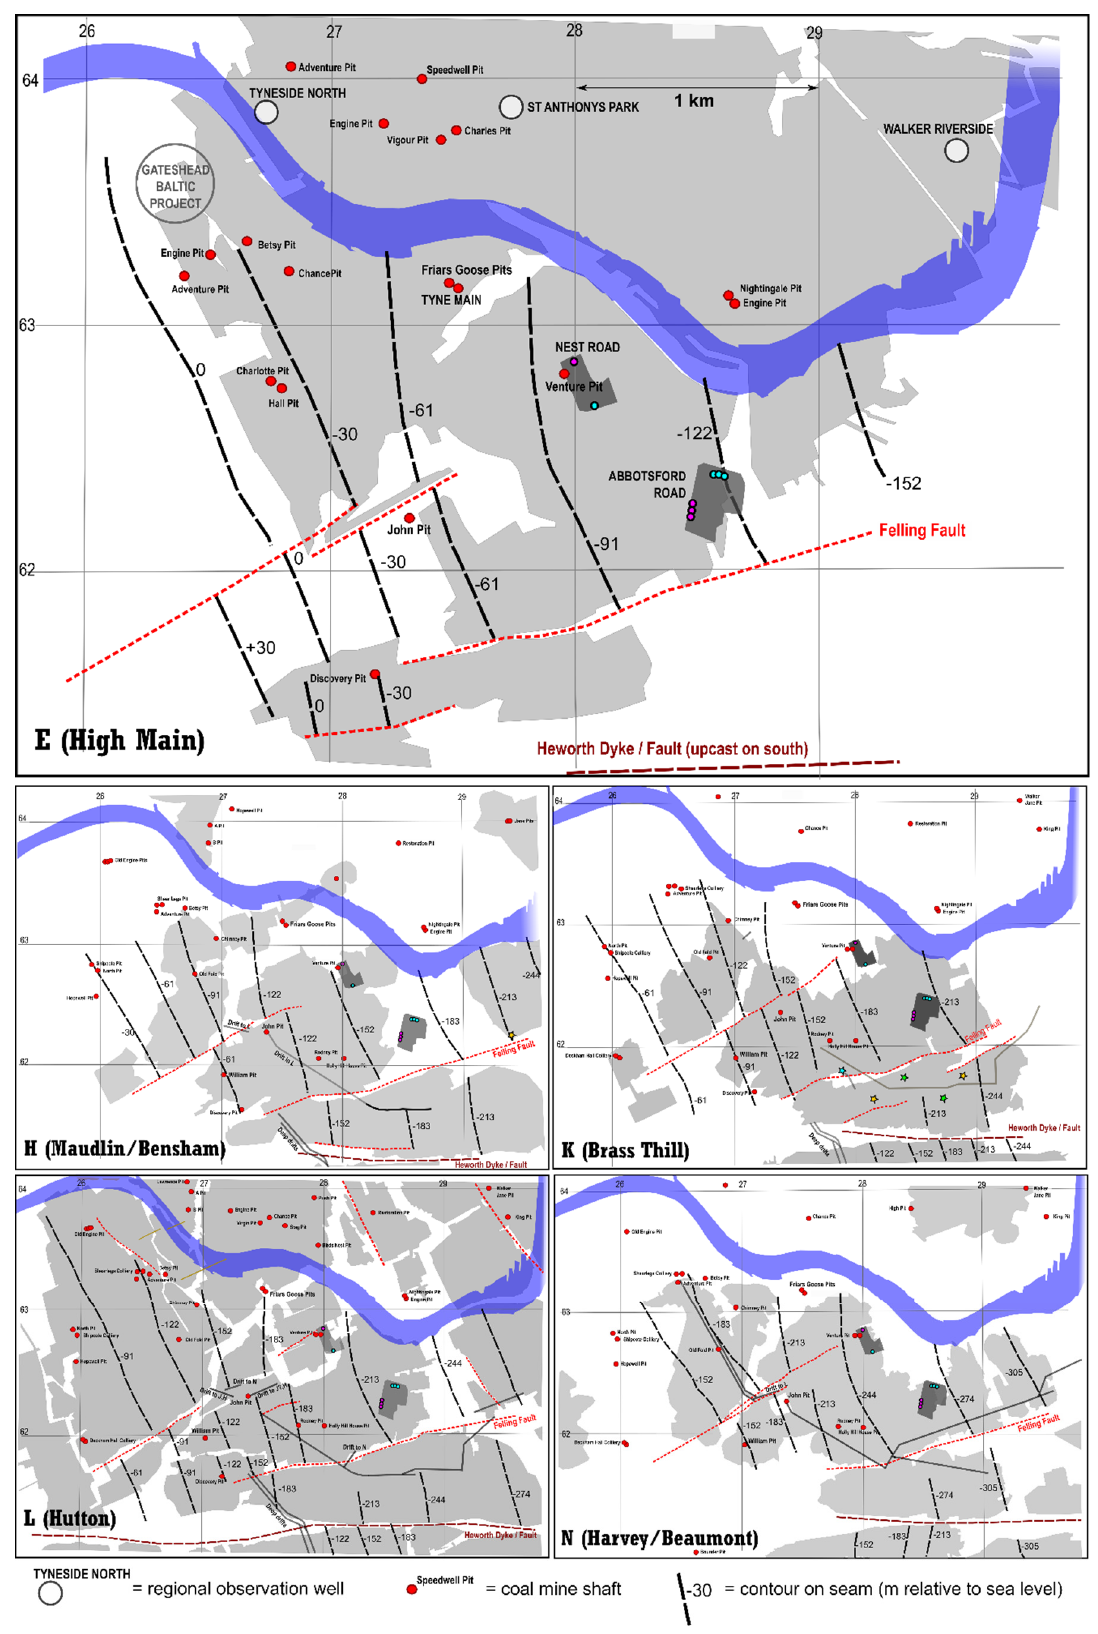
Figure 3. Schematic maps of Tyneside with footprints of workings, major coal pits, faults, structure contours and regional Observation Boreholes (OBH) indicated.